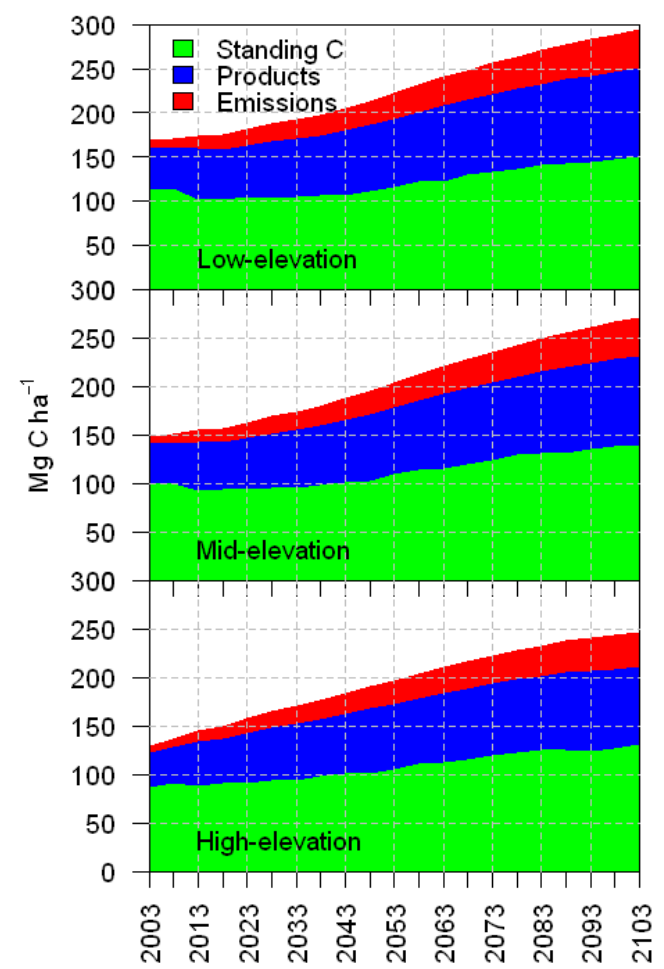
Figure 3. Cumulative aboveground live C, C stored in forest products and C released as emissions (Mg ha − 1 ) for three elevation groups under the even-aged management